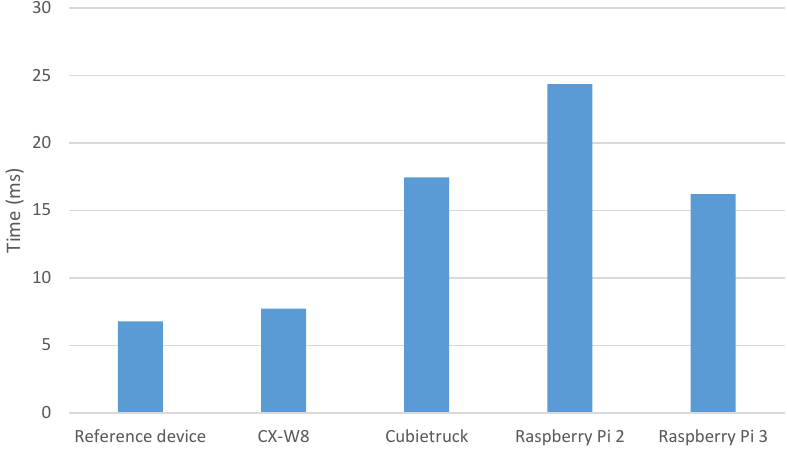
Figure 10. Mean times of SNMP protocol.